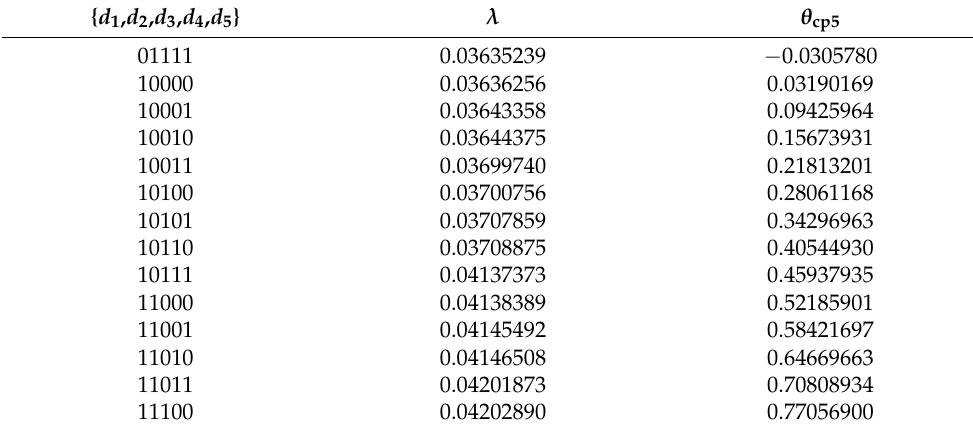
Table 3. Prediction constant table for 16-bit precision